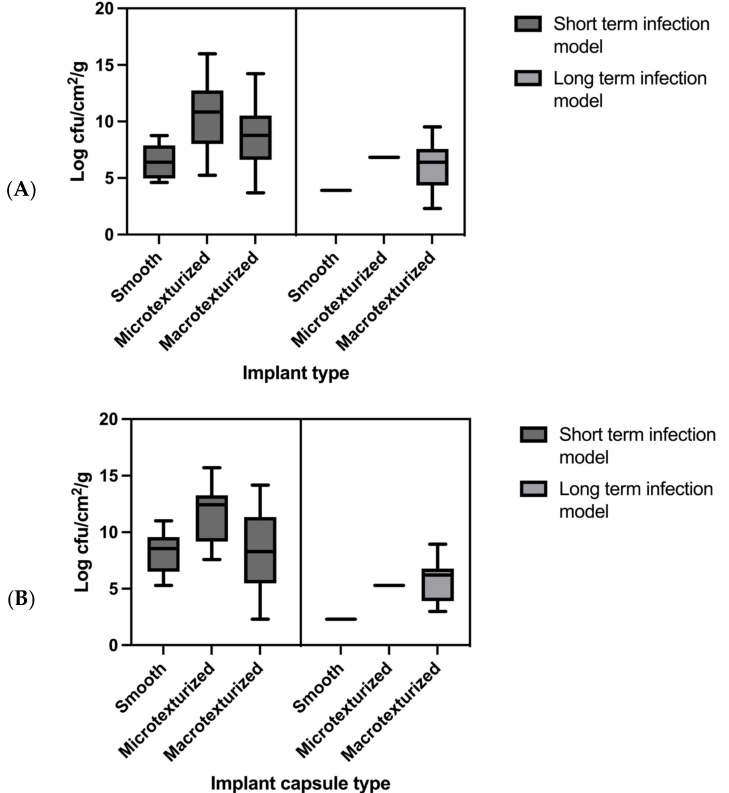
Figure 4. ( A ). Implant bacterial counts in short and long-term infection. ( B ). Capsule bacterial counts in short and long-term infection.